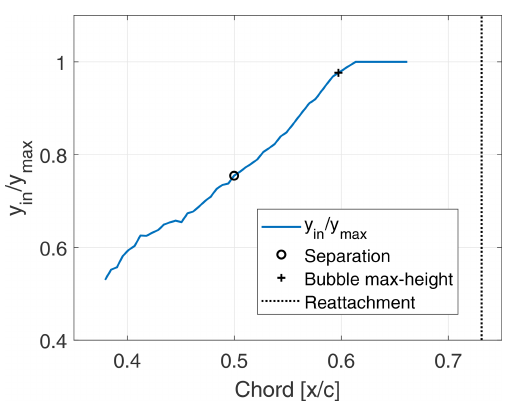
Figure 9. Ratio of the location of the inflection point to the loca- tion of the peak production of turbulent kinetic energy of the dis- turbances indicating the increasing importance of the inflectional